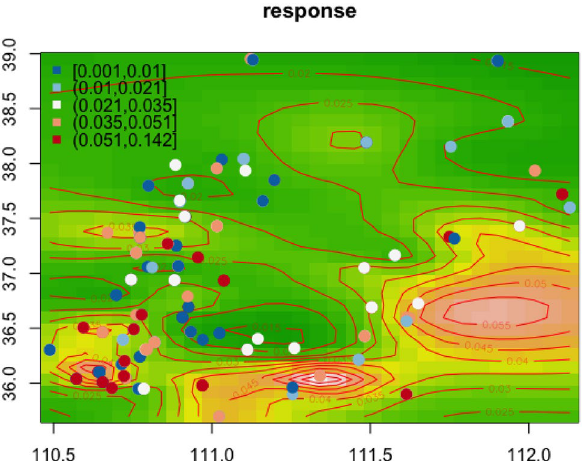
Figure 10. Spatial contours of predicted collapsibility contour with original values overlaid; x-axis: lontitude; y-axis: latitude.